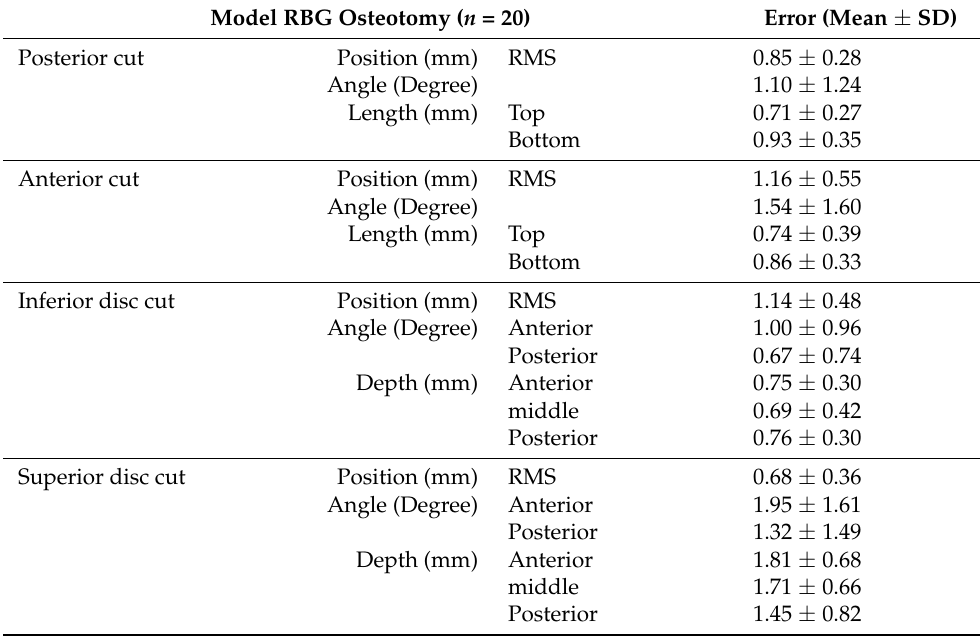
Table 2. Accuracy evaluation due to the category of errors on model RBG osteotomy. Category Error (Mean ± SD) Position (mm)